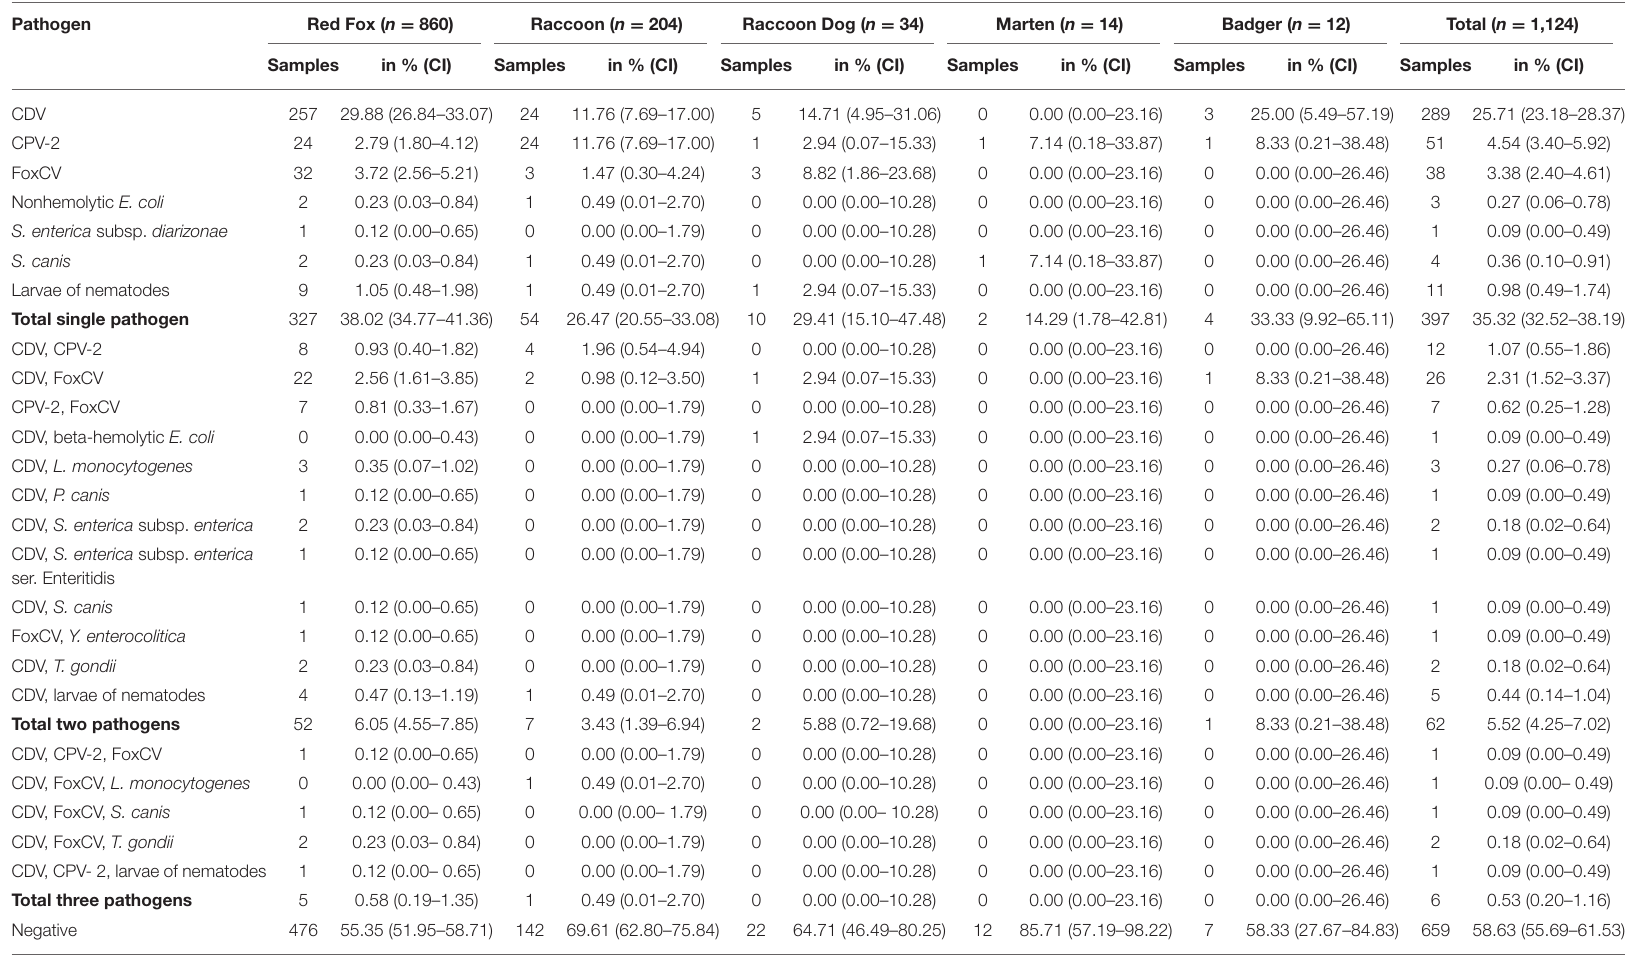
TABLE 4 | Animals with detected infectious pathogens including combinations of different